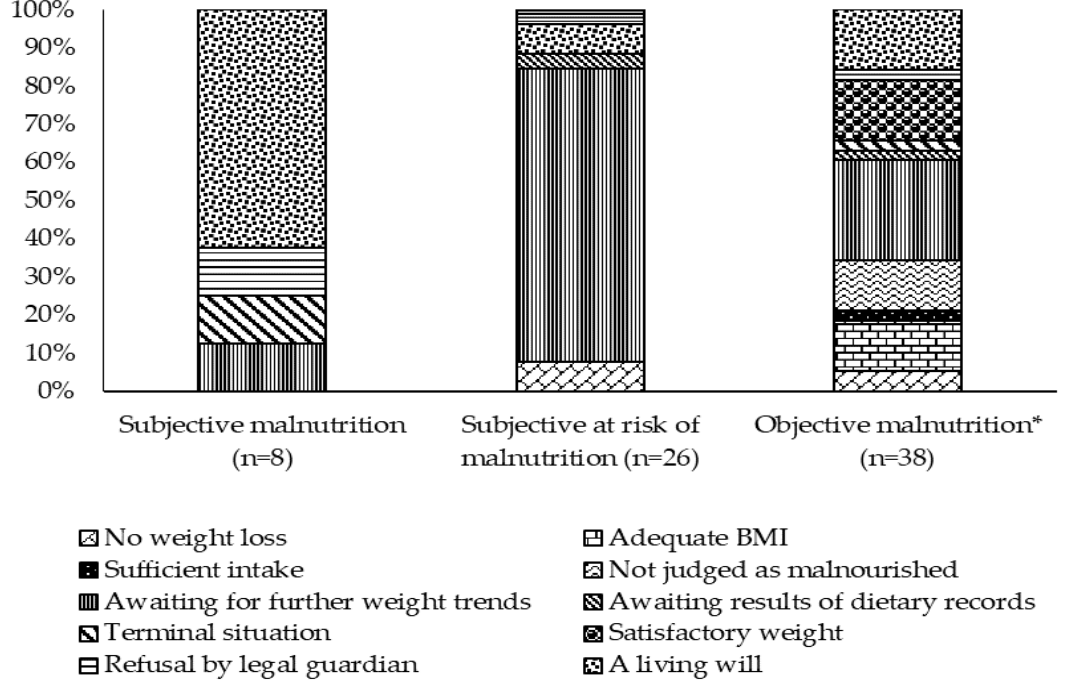
Figure 3. Reasons against nutritional interventions (%) despite (risk of) malnutrition according to subjective rating of malnutrition by nursing staff and objective rating of malnutrition (* BMI < 20 kg/m 2 or weight loss ≥ 5% in last 3 months or intake ≤ 1/4 of the meal). Table 2. Reasons against nutritional interventions (NI) stated by nursing staff and presence of ob ‐ jective signs of malnutrition in 38 objectively malnourished residents who did not receive NI. Num ‐ bers in () represent number of residents with the respective reason.